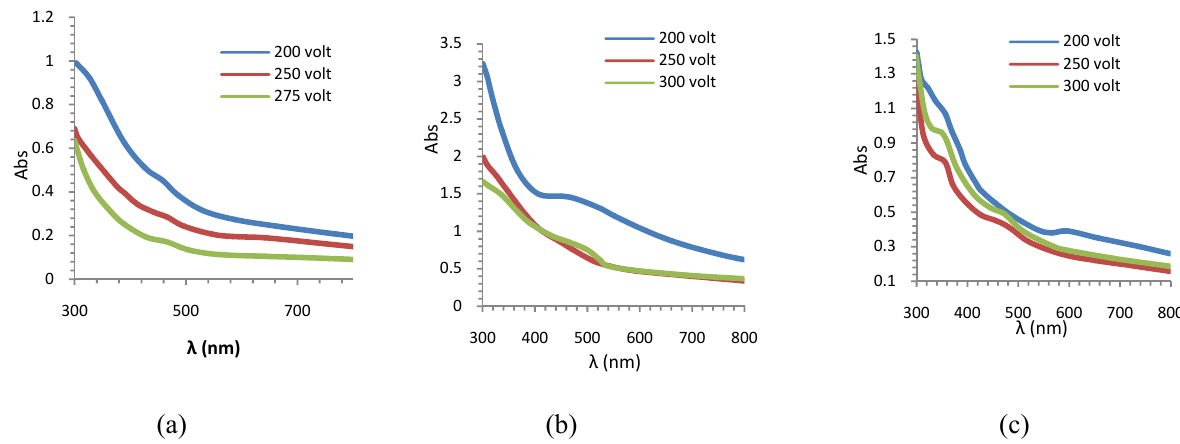
Fig.4: (a) UV-VIS. spectra of Cu colloid prepared by EEW in PVP with diameter of wire a- 0.2mm b- 0.3mm and c- 0.4mm.